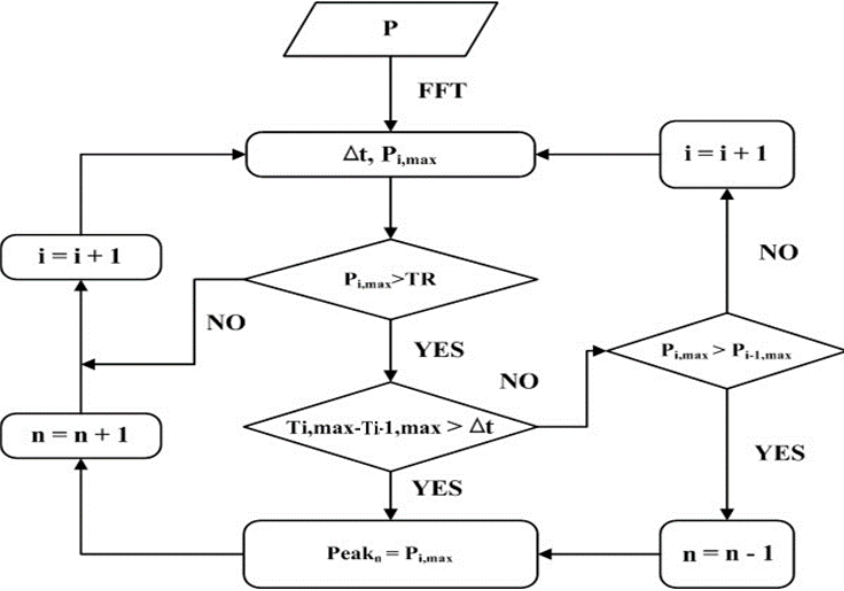
Figure 7. Scheme of Peak Pressure Detection.